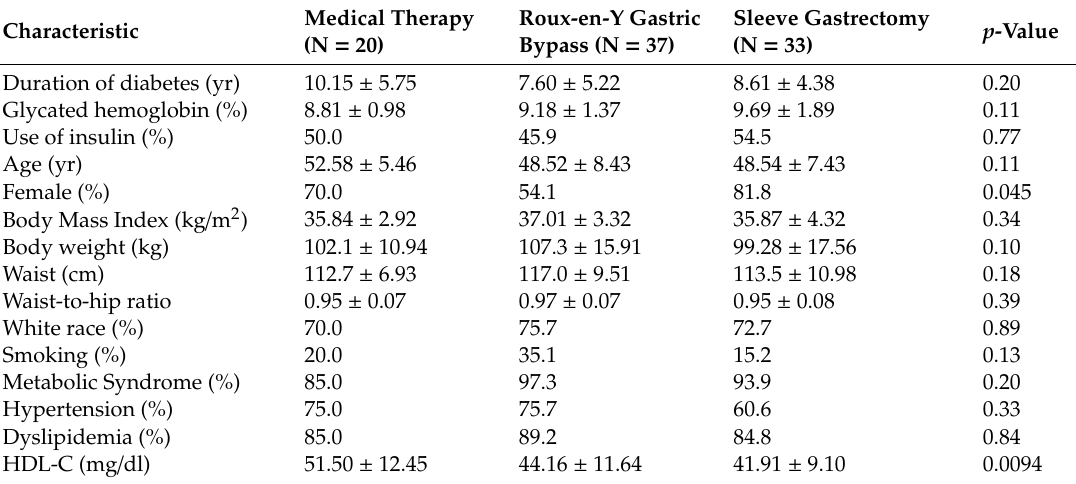
Table 1. Female percentage was significantly di ff erent among three groups, as was HDL-C levels, with RYGB and SG groups having lower HDL-C than the medical therapy group at baseline (Table 1). Table 1. Baseline characteristics of the STAMPEDE